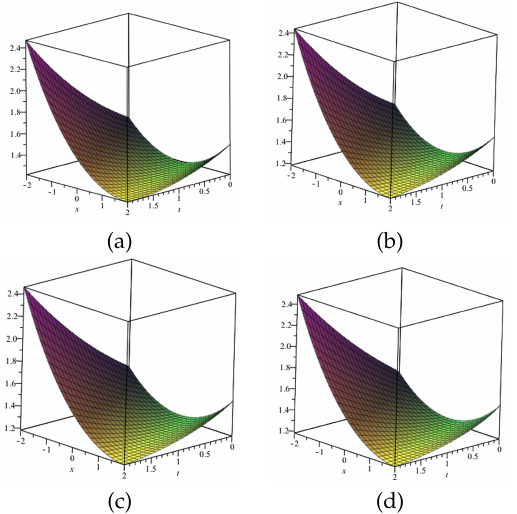
Fig. 3. Solutionof Eq. (23) using the 3-iteration of DJM for several values of α when c=1 : (a) exact ( α =1) , (b) α =1 , (c) α =0.95 and (d) α =0.9 .